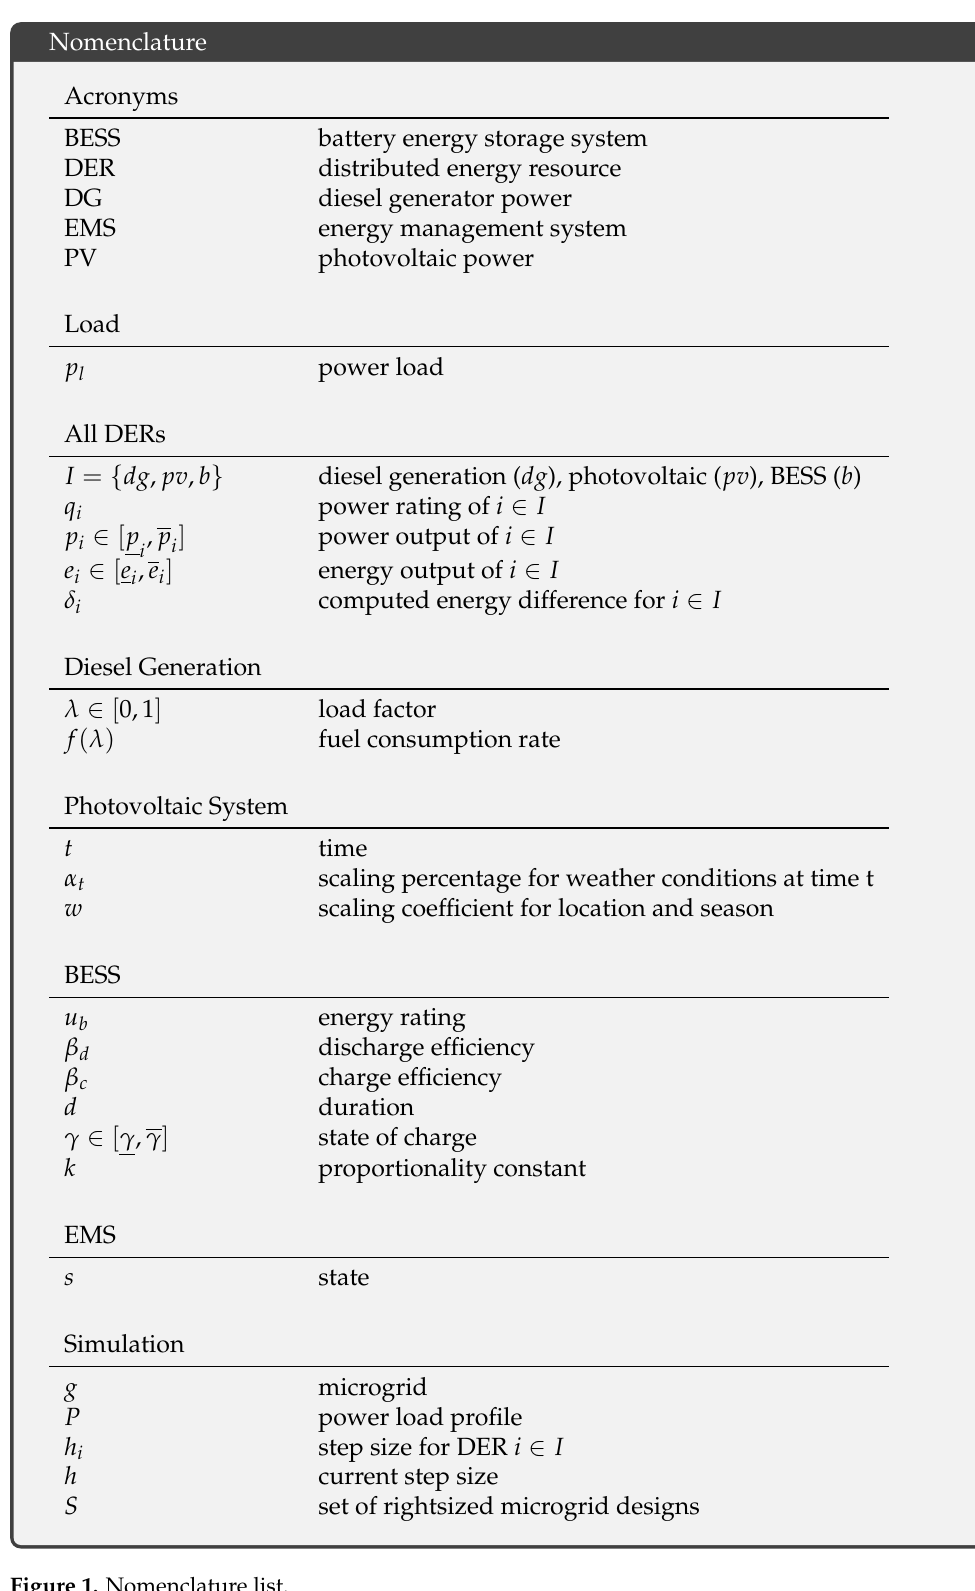
Figure 1. Nomenclature